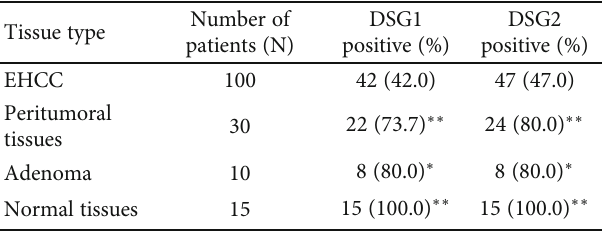
Table 3: The association between DSG1 expression and DSG2 expression in